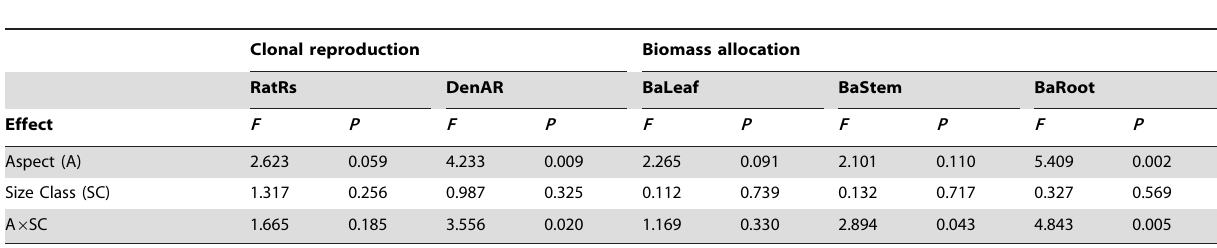
Table 2. Results of ANOVA for the effect of the aspect and size class on clonal reproduction and biomass allocation of Nitraria tangutorum